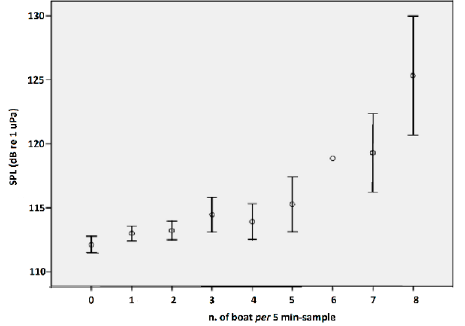
Figure 3. Variation of the mean (±standard error) sound pressure levels (SPLs) of recordings containing a variable number of boat passages.